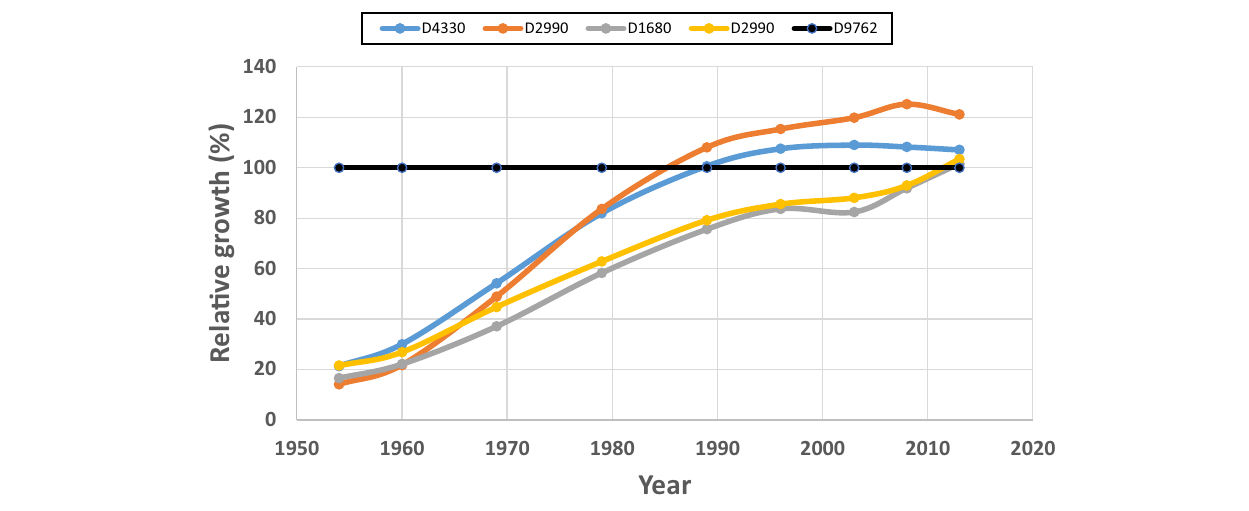
FIGURE 3 | Compensatory growth patterns for different sample plots within Block C of the MacKay thinning trial in Alberta, Canada, expressed as relative volume growth under different stand densities. Maximum relative volume growth was calculated as the ratio of the volume obtained in the treated vs. control stands (see Eq. 1). Data shows that plots with a same stand density can reach compensatory-induced-equity (CIE) by different